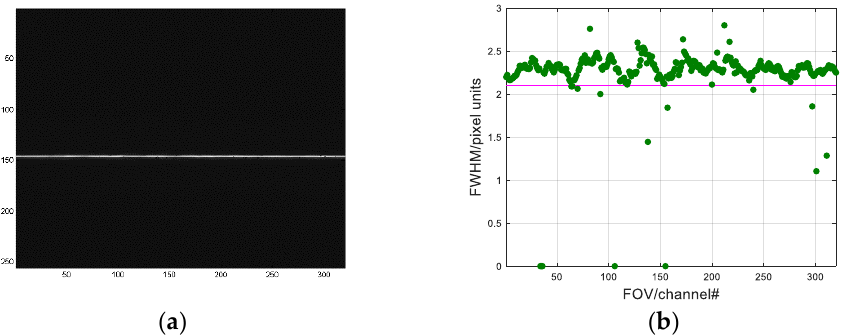
Figure 18. Imaging of the straight slit at 123 K. ( a ) The image of straight slit; ( b ) FWHM of straight slit image.